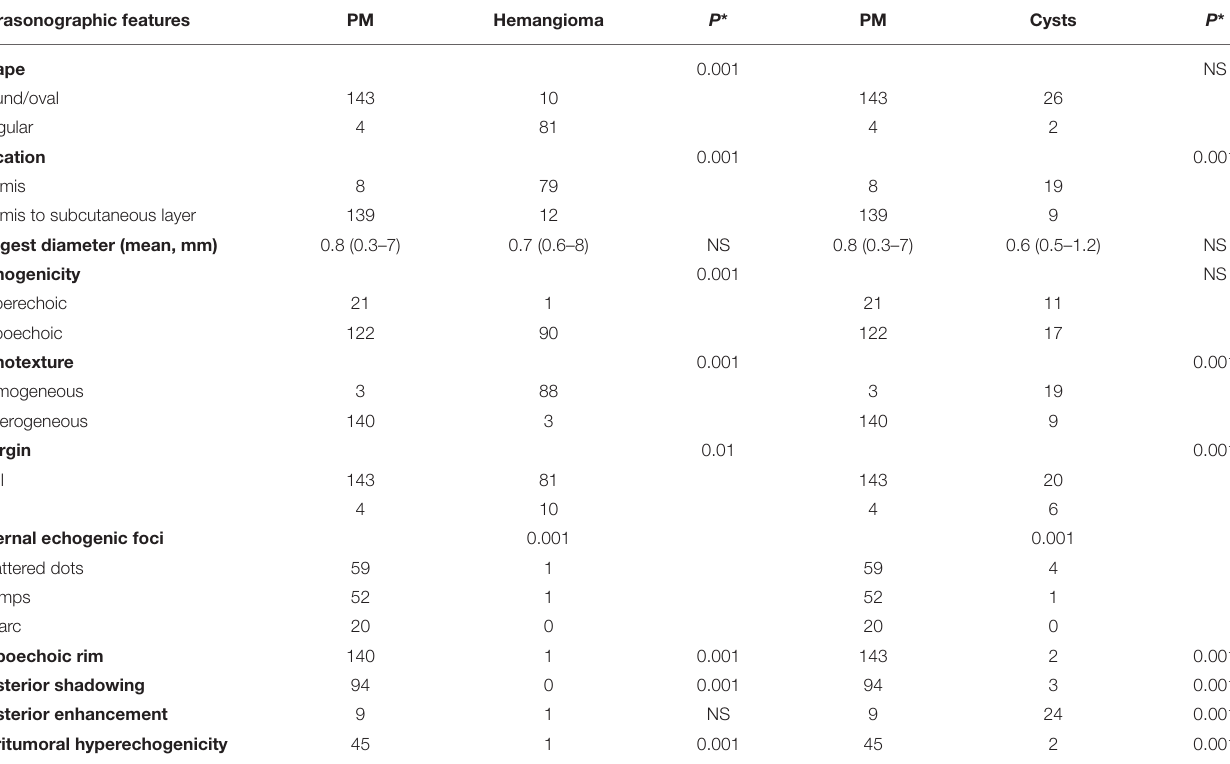
TABLE 2 | Comparison of PM with hemangioma and skin cysts on ultrasound. Ultrasonographic features PM Hemangioma Shape